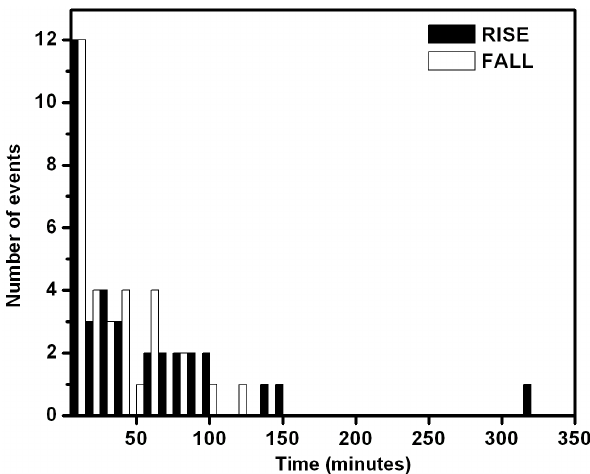
Fig. 5. Frequency distribution of the rise (solid bars) and fall (open bars) times of the sporadic events.